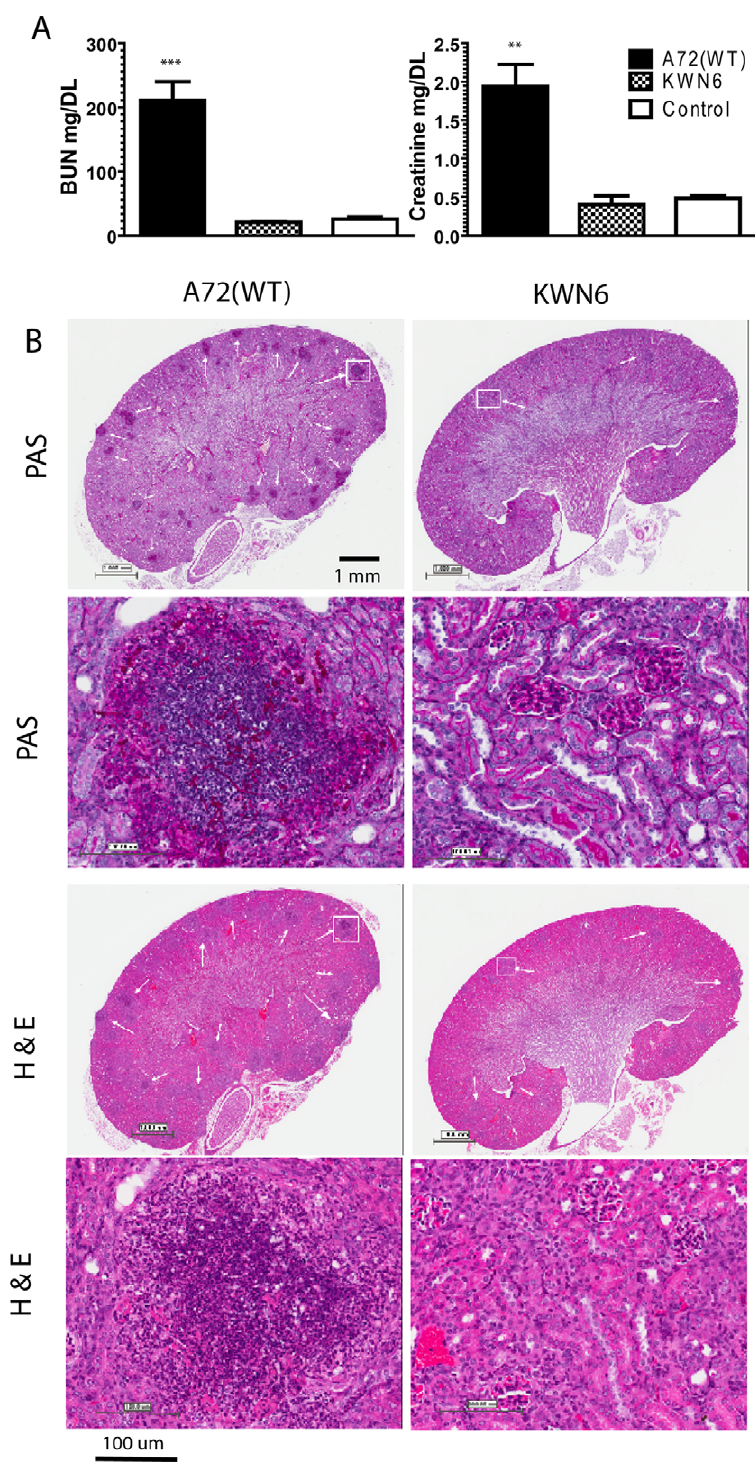
Figure 3. Dur1,2p expression impairs kidney function and increases inflammation. A . Kidney function tests of mice infected with A72 (WT) vs KWN6 at day 3 PI. Open bars represent serum levels of BUN and creatinine in non-infected control mice. Checkered bars represent KWN6 infected mice, and closed bars represent A72 (WT) infected mice. Note the levels of BUN and creatinine are significantly higher in WT infected sera compared with KWN6 infected mice. B. PAS and H&E-stained mouse kidney tissues to assess inflammatory responses and tissue necrosis caused by C. albicans colonization. Representative sections of infected mouse kidneys (group of 3 mice) harvested at day 3 PI are shown. Scale bars indicate magnification. Arrows indicate regions of PMN and C. albicans accumulation in PAS stains and PMN inflammatory foci in H&E stains. Demarcated regions by white squares are shown under higher magnifications in the lower panels.